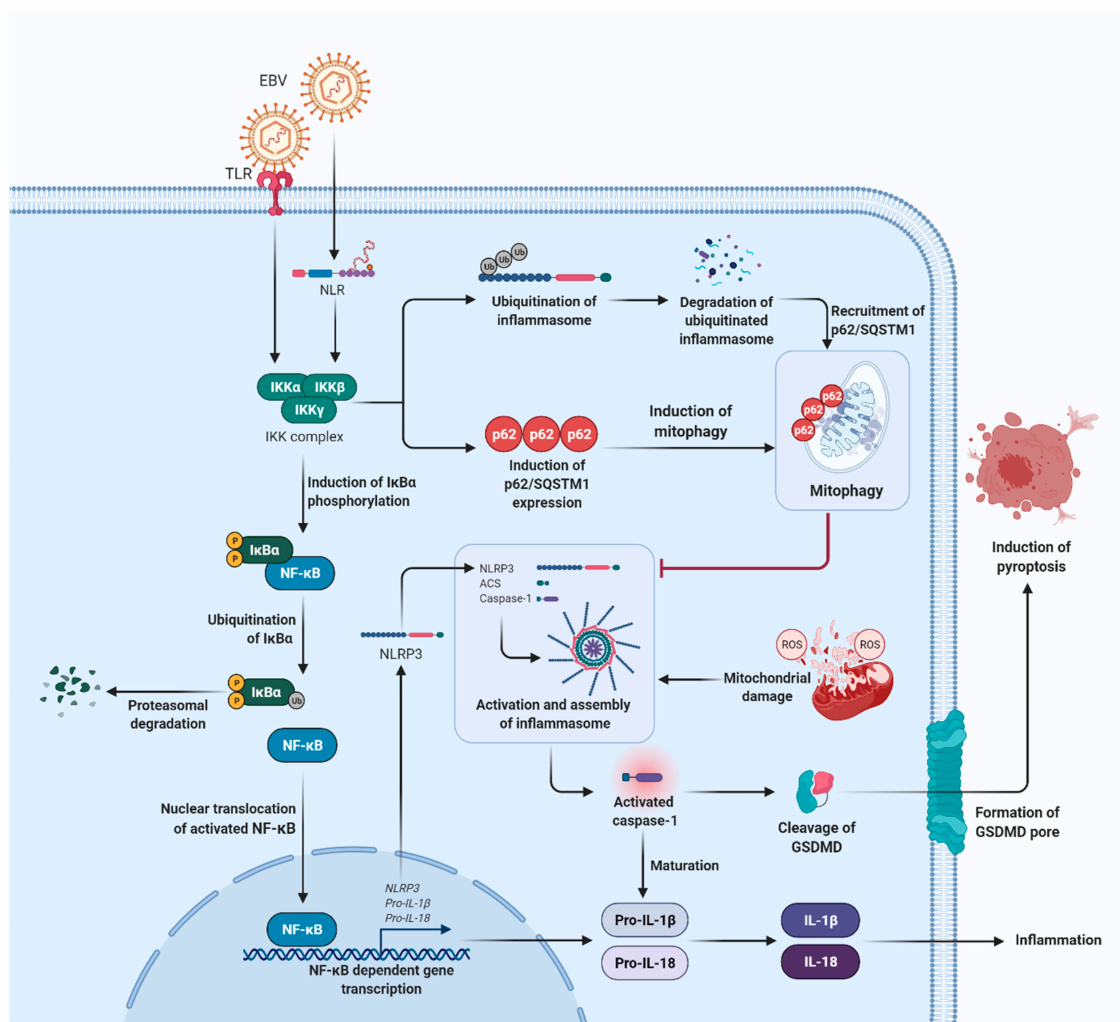
Figure 3. IKKs act as the negative regulator of inflammasome activation. IKK kinase complex which is made up of two kinases (IKK α and IKK β ) and a regulatory subunit (IKK γ ), is the key regulator of NF- κ B signalling. The phosphorylation of the inhibitor of NF- κ B proteins, particularly the I κ B α by IKKs, resulting in the ubiquitination and proteasomal degradation of I κ B α . The activated NF- κ B is then translocated into the nucleus to regulate target gene expression, which contributes to inflammasome activation, maturation and production of IL-1 β and IL-18. The ROS released from damaged mitochondria serve as an important inflammasome activating signal, however, IKKs can induce autophagy clearance of damaged mitochondria by inducing the expression and accumulation of autophagy receptor, p62/SQSTM1. In addition, degradation of inflammasome components through ubiquitination triggers expression of p62/SQSTM1, and hence, negatively regulates inflammasome activation by promoting mitophagy. (IKK, inhibitory kappa B kinases; NF- κ B, nuclear factor kappa B; I κ B α , inhibitory subunit of nuclear factor kappa B alpha; ROS, reactive oxygen species; p62/SQSTM1,